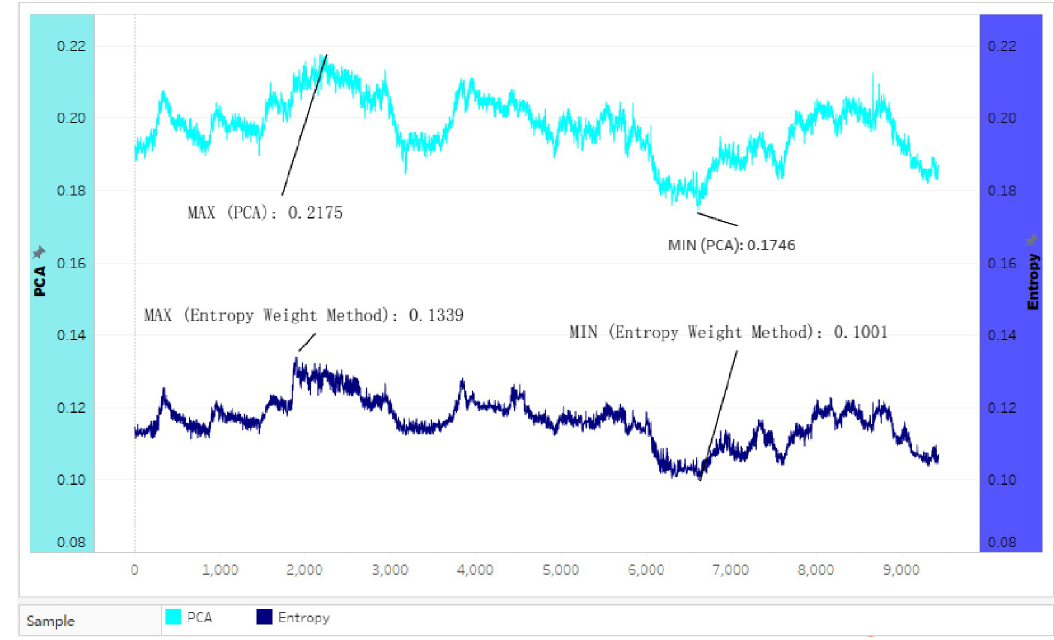
Fig 9. Two curves of the weighted index between the PCA and the entropy in Case Study 2. https://doi.org/10.1371/journal.pone.0262261.g009 the lowest (17.46%). The average of Std. Deviation is 0.0032, which is very small. Therefore, the two weighted curves were very close (Fig 8). The curve of weighted dataset values com- puted by the PCA method (with blue color) was lower than the curve by the Entropy method (with deep blue color). The PCA appeared to be a more responsive method than Entropy to Case Study 1. Other studies also have different advantages of the PCA method. The PCA method can effectively reduce computational complexity and rapidly select solutions to emer- gency decision-making in a large dataset group [62]. Notably, the PCA method was sensitive